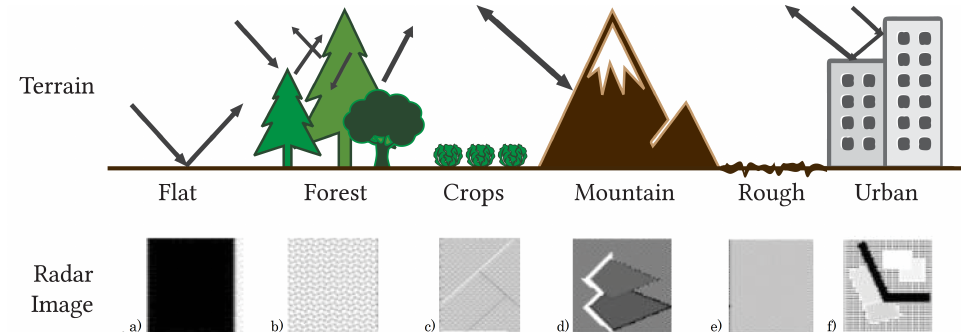
Figure 2. Types of reflections generated by different surfaces. From left to right, ( a ) a flat surface, such as water, makes the wave reflect forward without any reflection back; ( b ) forest and vegetation generates multiple signal reflections but highly attenuated due to penetration in the trees; ( c ) cul- tivation fields are similar to the forest, but have less attenuation; ( d ) the inclination of mountains generates direct reflections to the sensor on the illuminated side, but no reflection at all on the other; ( e ) irregular terrain produces scattered reflections; ( f ) urban buildings tend to create reflections with high intensity, but small streets represent a complete absense of reflections.